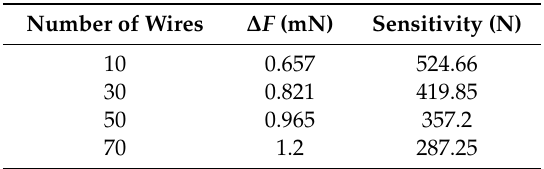
Table 6. Calculation of the sensitivity of the filter considering a distance between wires d = 18.5 µ m a reflectance S 11 =